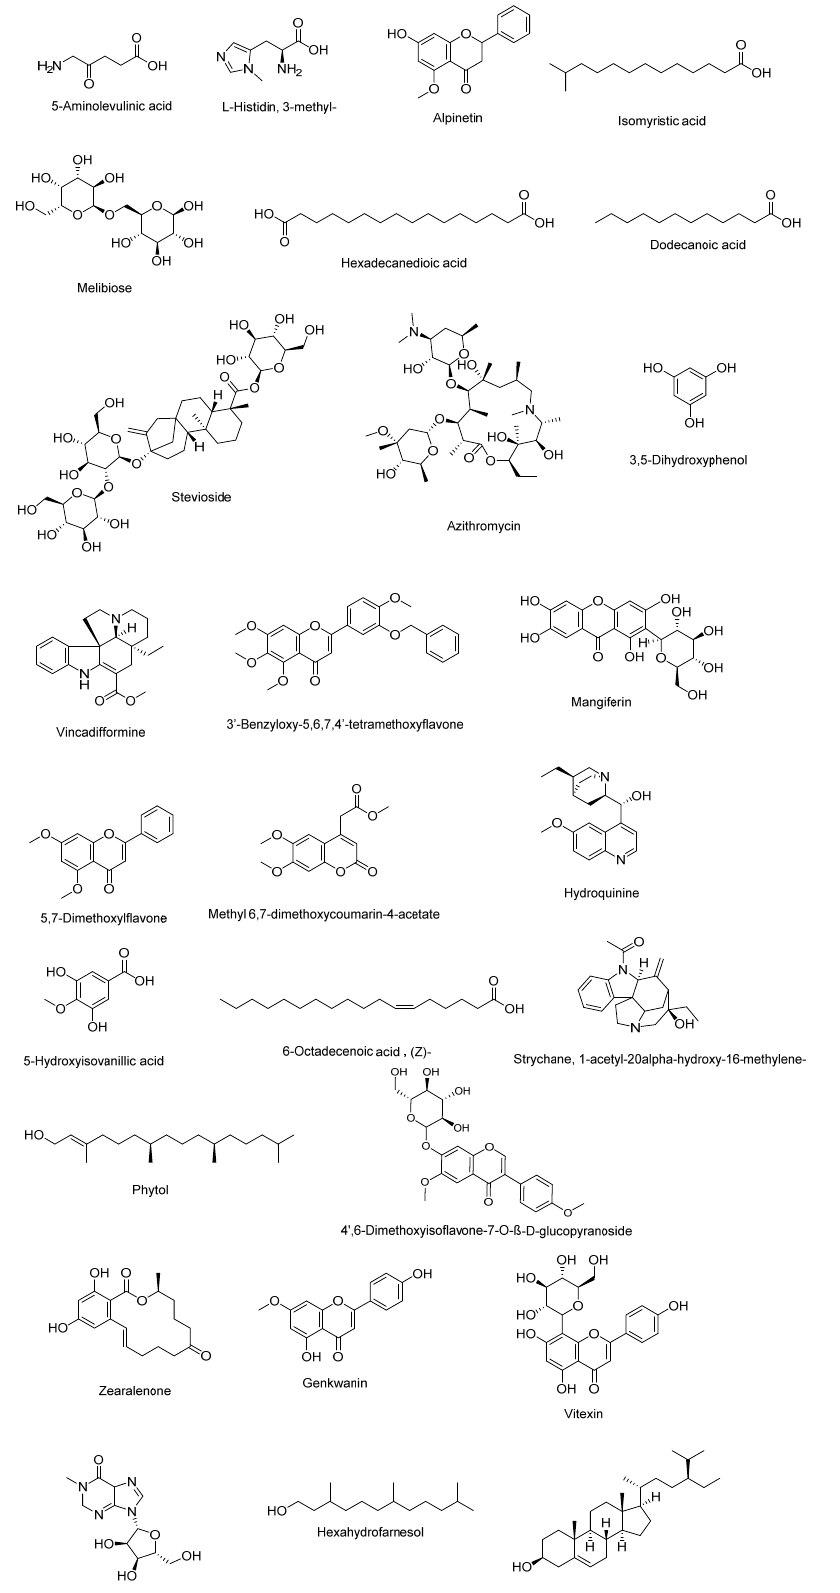
Figure 4. Molecules identified of the methanolic extract of the fruit of C. maxima.